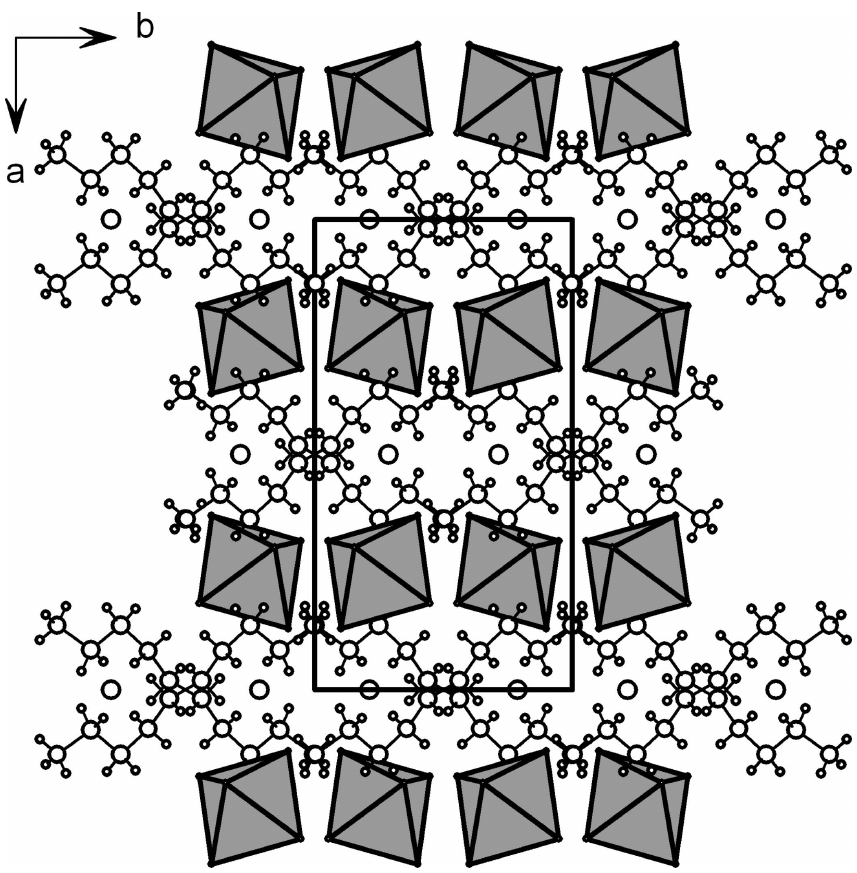
Figure 2 Packing diagram, view along [001]. The [RhCl